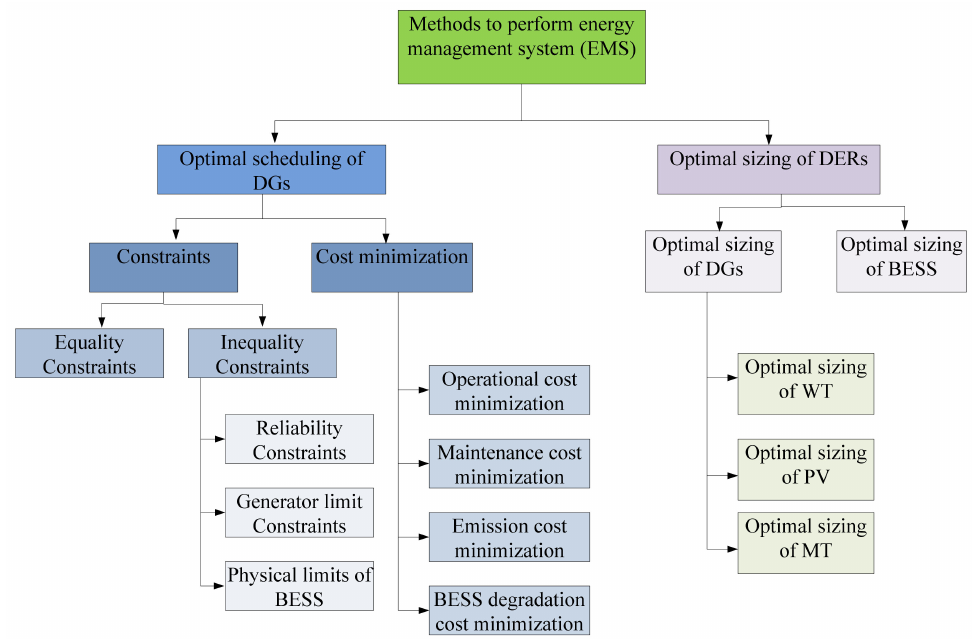
Figure 6. Long-term methods to perform EM in the MG system from source end.